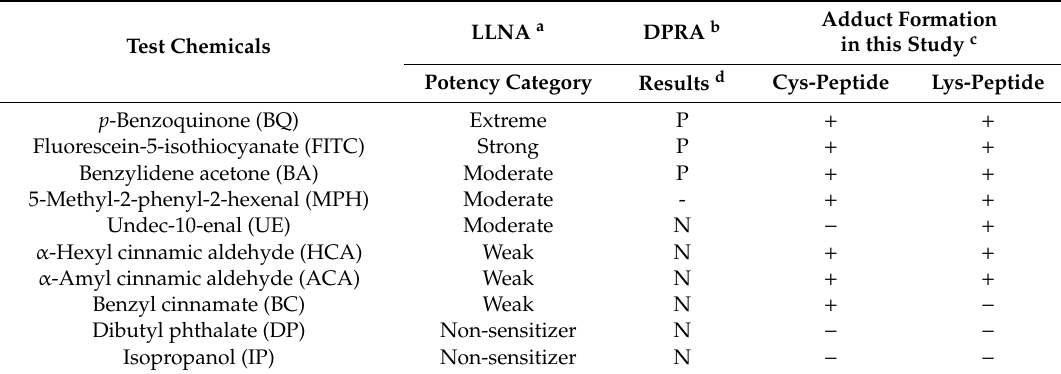
Table 1. Summary of signals for the peptide adducts.